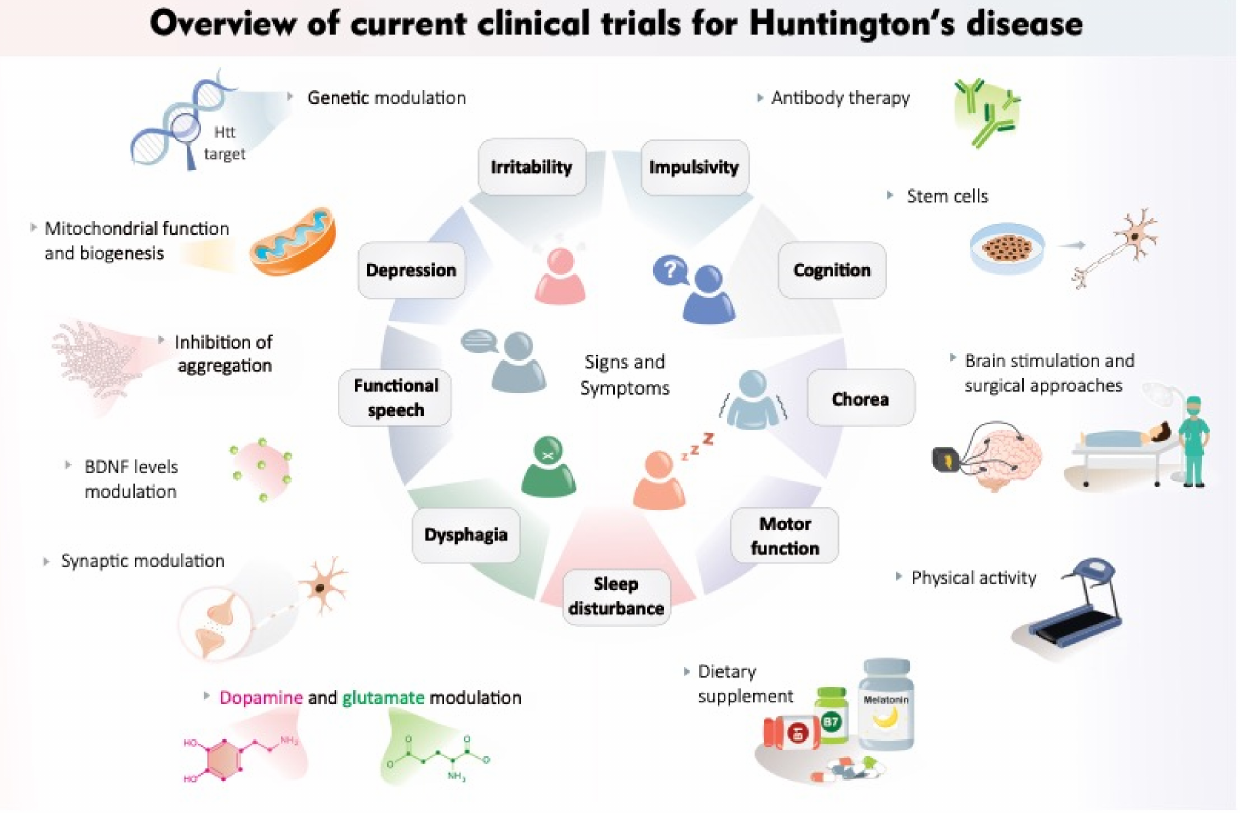
Figure 1. Overview of current clinical trials for Huntington’s